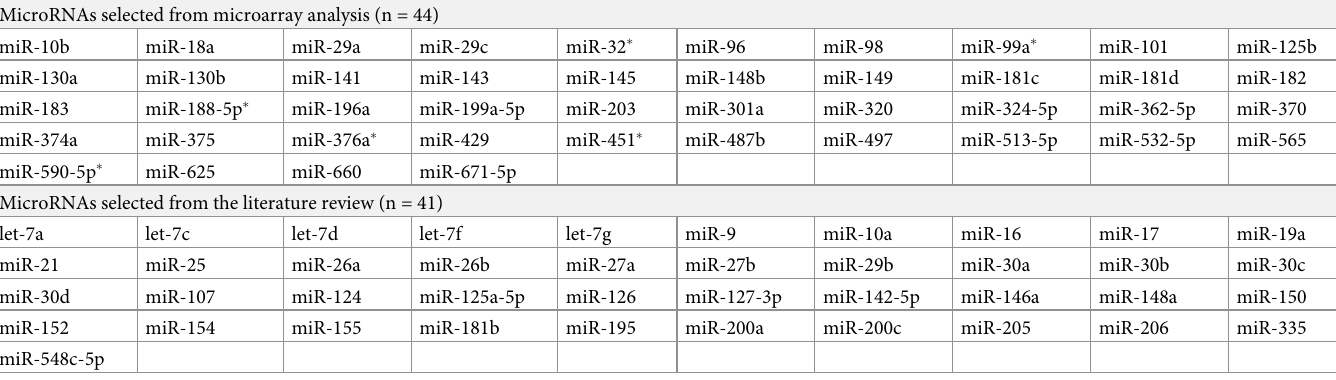
Table 2. List of selected candidate miRNAs for subsequent qPCR analysis. MicroRNAs selected from microarray analysis (n =